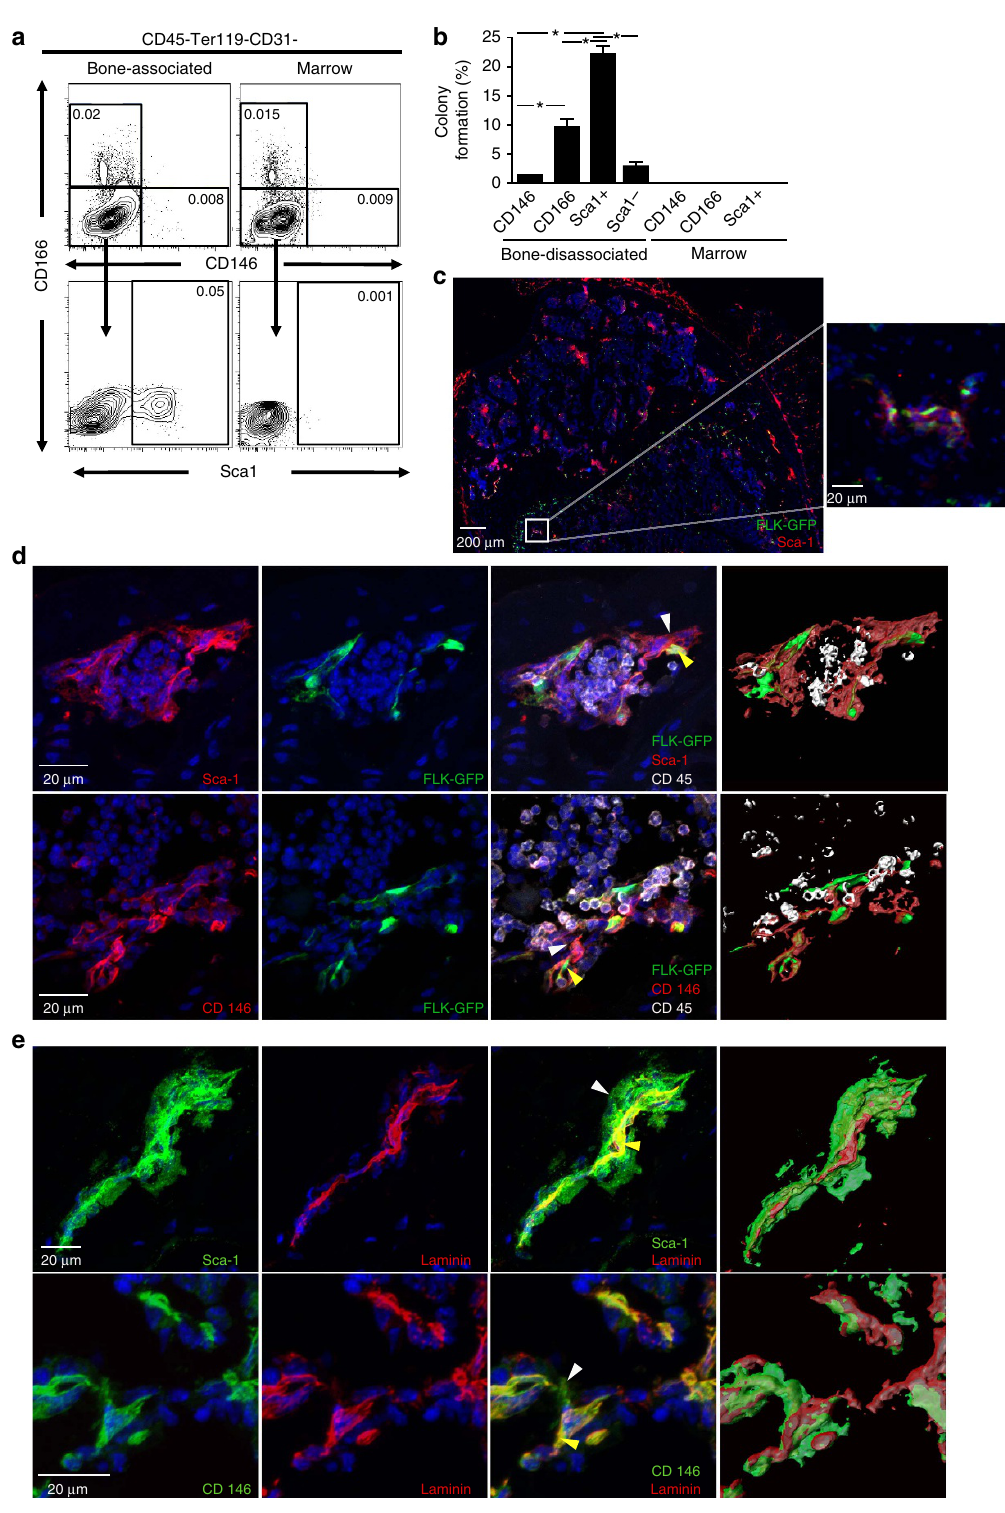
Figure 1 | Phenotypic Identification of three bone-disassociated mesenchymal progenitors. ( a ) Representative FACS profiles of stromal cells (CD45 (cid:2) Ter119 (cid:2) CD31 (cid:2) ) near the endosteum (bone-disassociated). They were separated based on their CD166, CD146 and Sca1 expression profiles. Numbers shown in the gate represent the percentage of total live cells. ( b ) Single-cell colony forming efficiency of BM stromal progenitors (*: P r 0.05, three repeats of 60 cells each, student’s t -test). ( c ) Sections of femur from Flk1-GFP mouse stained with antibodies against Sca1 and scanned with an iCys Research imaging cytometer. Nuclei were stained with Dapi. ( d ) Confocal maximum intensity projections of sections of femurs from Flk1-GFP mice stained with antibodies against Sca1 or CD146; scanned near the epiphyseal plate. ( e ) Confocal maximum intensity projections of sections of femur stained with antibodies against Sca1 or CD146 and laminin; scanned near epiphyseal plate. White arrows point to mesenchymal progenitors yellow arrows point to endothelial